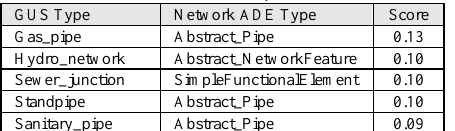
Table 9. Wordnet matching between GUS-InfraGML GUS Type InfraGML Type